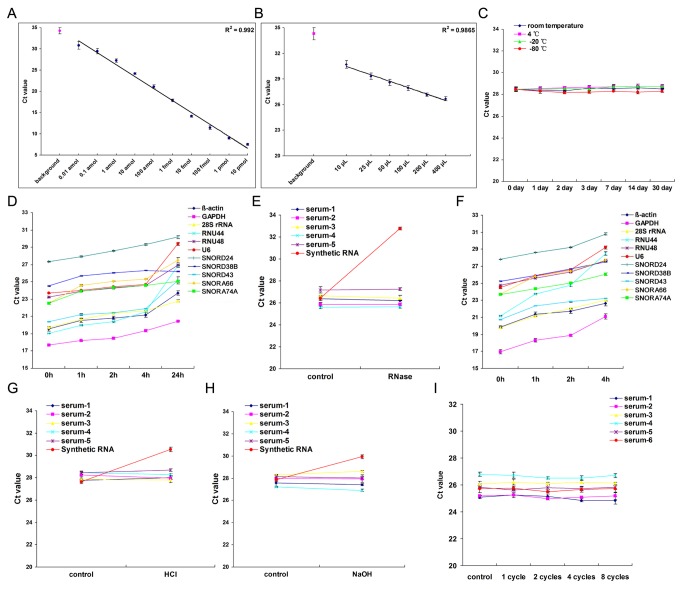
Characterization of the absolute concentration and the stability of let-7d/g/i in serum.(A) Dynamic range and sensitivity of the RT-qPCR assay for measuring let-7d/g/i (n = 5). Synthetic single-stranded let-7d/g/i ranging from 0.01 attomole (0.0033 attomole each, equivalent to 6×103 copies in total) to 10 pmol (3.3 pmol each) were serially diluted over ten orders of magnitude and were assessed by the RT-qPCR assay. The resulting Cq values were plotted versus the amount of input let-7d/g/i to generate a standard curve. An assay using water instead of RNA for reverse-transcription was included as a negative control. (B) Correlation of serum volume to the Cq values (n = 5). Total RNA was extracted from different volumes of serum ranging from 10 µL to 400 µL. The levels of serum let-7d/g/i were assessed by RT-qPCR. The resulting Cq values were plotted versus the serum volume used for RNA extraction. An assay using water instead of RNA for reverse-transcription was included as a negative control. (C) Stability of let-7d/g/i in serum after extended storage (n = 5). Serum samples were equally divided and stored at room temperature, 4°C, -20°C or -80°C for 1, 2, 3, 7, 14 or 30 days. For each time point, total RNA was isolated and let-7d/g/i was measured by RT-qPCR assay. Storage at room temperature for 30 days yielded no apparent increase in Cq values. (D) Instability of other RNAs in serum (n = 5). Serum samples were equally divided and stored at room temperature for 1 to 24 h. For each time point, total RNA was isolated, and the levels of some large molecular weight RNA (β-actin, GAPDH and 28S rRNA) and snRNA/snoRNA (U6, RNU44, RNU48, SNORD24, SNORD38B, SNORD43, SNORA66 and SNORA74A) were measured by RT-qPCR. Storage at room temperature for 24 h resulted in an apparent increase of Cq values for these RNAs. (E) Stability of let-7d/g/i in serum after RNase digestion (n = 5). Serum samples were treated with 10 U/ml RNase A and 400 U/ml RNase T1 for 4 h at 37°C. After the treatment, the RNA was extracted from the serum, and the levels of let-7d/g/i were assessed by RT-qPCR. (F) Instability of other RNAs in serum after RNase digestion (n = 5). Serum samples were treated with 10 U/ml RNase A and 400 U/ml RNase T1 for 1, 2 or 4 h at 37°C. After the treatment, the RNA was extracted and the levels of the indicated RNAs were assessed by RT-qPCR assay. (G and H) Stability of let-7d/g/i under acidic or alkaline conditions (n = 5). Serum samples were incubated for 1 h under acidic (pH 2) or alkaline (pH 12) conditions. The levels of let-7d/g/i were assessed by RT-qPCR. (I) Stability of let-7d/g/i in serum following re-freezing and re-thawing of the samples (n = 6). Serum samples were subjected to eight freeze-thaw cycles.